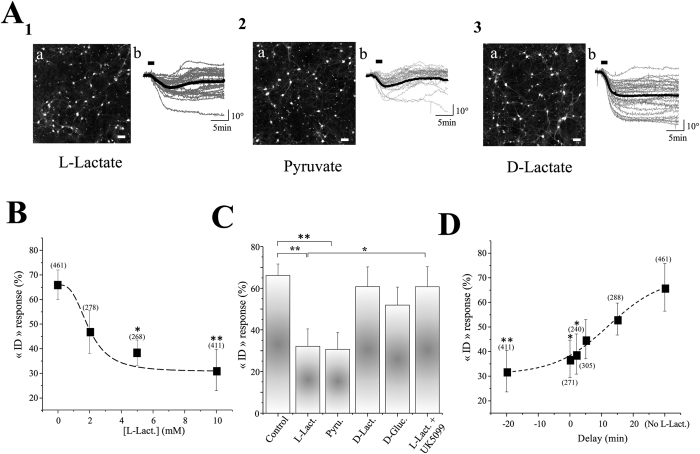
L-Lactate is neuroprotective through mitochondrial ATP formation.(A1) (a) Representative phase images of neuronal culture with L-Lactate (10 mM) in the Mg2+ free ACSF (scale bar: 50 μm). (b) Individual (grey line) and averaged (black line) traces of QPS recorded from cultured neurons. Note that the averaged trace obtained after glutamate application (100 μM, 2 min; bar) is an “RD” response. (A2, A3) Representative phase images (a), individual (grey line) and averaged (black line) traces of QPS (b) recorded from cultured neurons treated with Pyruvate (A2) or D-Lactate (A3). Similarly to L-Lactate, the averaged trace obtained after glutamate application is an “RD” response with Pyruvate. In contrast, the averaged trace of QPS is an “ID” response with D-Lactate. (B) Concentration-response curve representing the effect of L-Lactate at different (0 to 10 mM). Results are data are presented as means ± SEM (*p < 0.05, **p < 0.01, One-way Anova/post-test “Dunnett”). Numbers in brackets are the number of cells in each sampling. (C) The Bar chart shows percentage of glutamate-induced “ID” responses obtained in Mg2+ free ACSF containing 5 mM of D-glucose (control) (ncult = 16; ncell = 461), or supplied with L-Lactate (L-Lact., 10 mM) (ncult = 15; ncell = 411), Pyruvate (Pyru., 10 mM) (ncult = 10; ncell = 265). D-Lactate (D-Lact., 10 mM) (ncult = 11; ncell = 305), D-Glucose (D-Gluc., 5 mM) (ncult = 10; ncell = 286) or L-Lactate (10mM) + UK5099 (1μM) (ncult = 9; ncell = 248). Results are data are presented as means ± SEM (*p < 0.05; **p < 0.01, One-way Anova/post-test “Dunnett”). (D) Histogram representing the effect of L-Lactate at different time points (20 min before; 0 min, 2 min, 5 min and 15 min after) of glutamate application. Note that L-Lactate remains efficient to neuroprotect even when it is applied up to 2 min after glutamate application. Results are data are presented as means ± SEM (*p < 0.05; **p < 0.01, One-way Anova/post-test “Dunnett”). Numbers in brackets are the number of cells in each sampling.